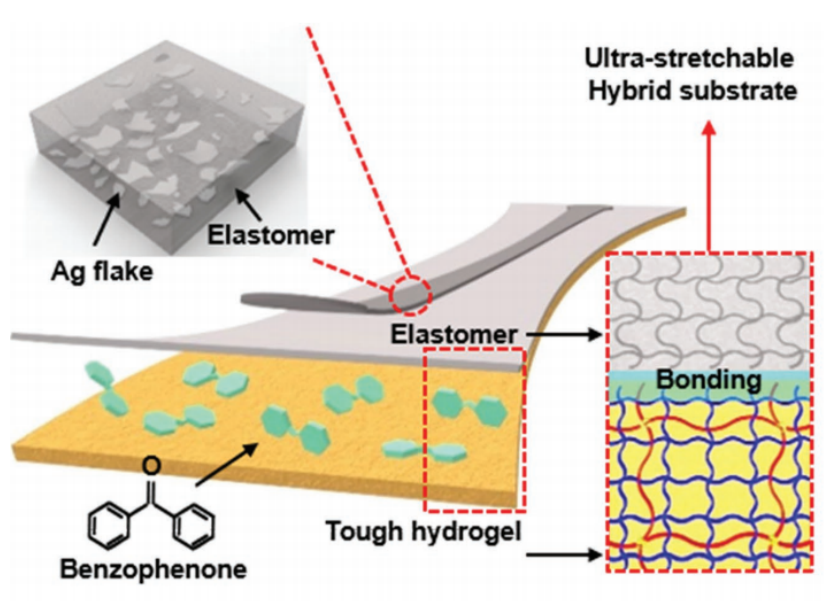
Figure 9. Schematic illustration of the conductor composition. The thin elastomer film is strongly bonded to the tough hydrogel layer by benzophenone. Reprinted with permission from